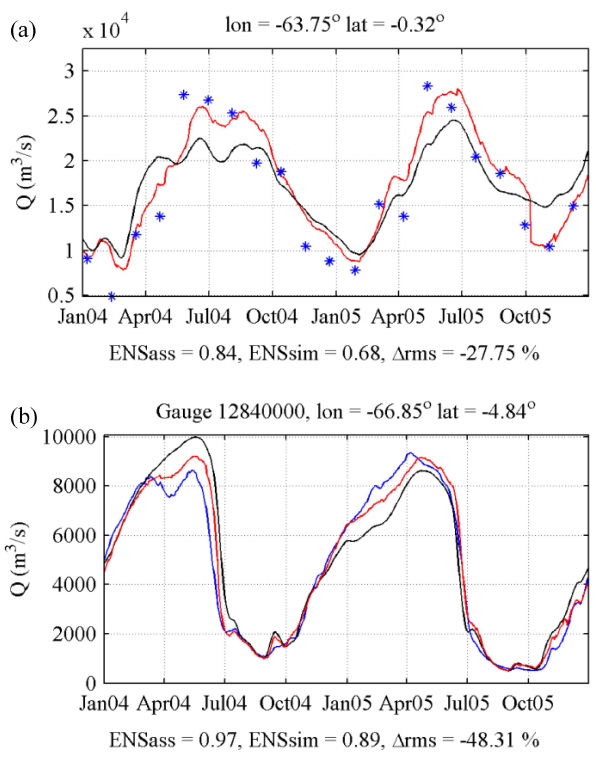
Fig. 7. Observation (blue line), open-loop simulation (black line) and EnKF simulation (red line) of discharge at (a) Negro River al- timetry site and (b) Juru´a River in situ site. Sites are indicated in Fig. 6.